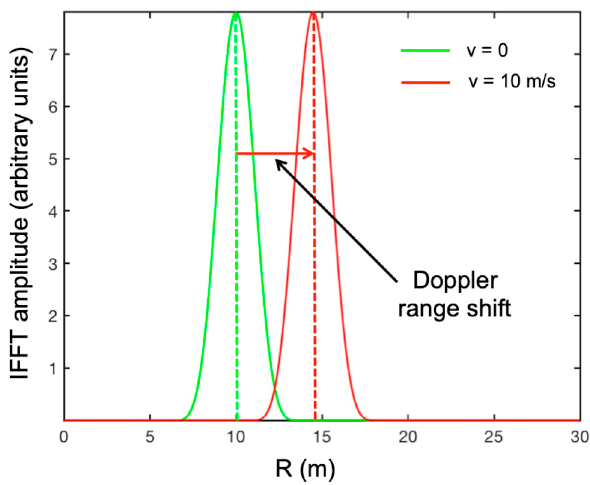
Figure 3. Example of the Doppler range shift. The green curve is the inverse fast Fourier transform (IFFT) amplitude of a static target, the red curve is the IFFT amplitude of a target moving away from the radar (in the radar-target direction) at speed v = 10 m/s.